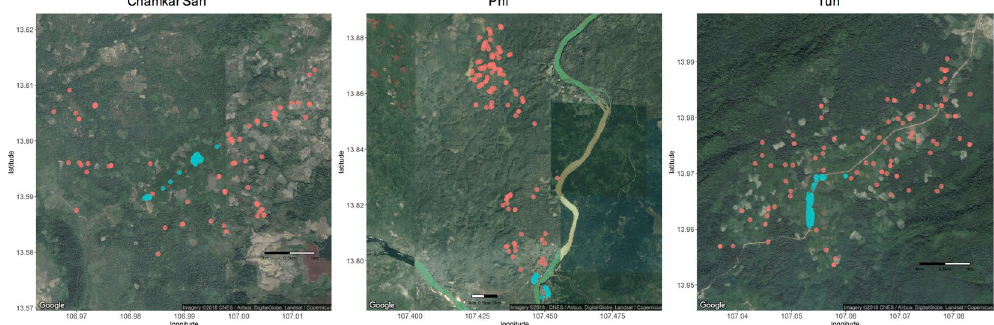
Figure 1. Location of village and farm houses in Chamkar San, Tun and Phi. Red circles indicate farm houses, blue circles indicate village houses. Map Data ©2018, CNES/Airbus, DigitalGlobe,